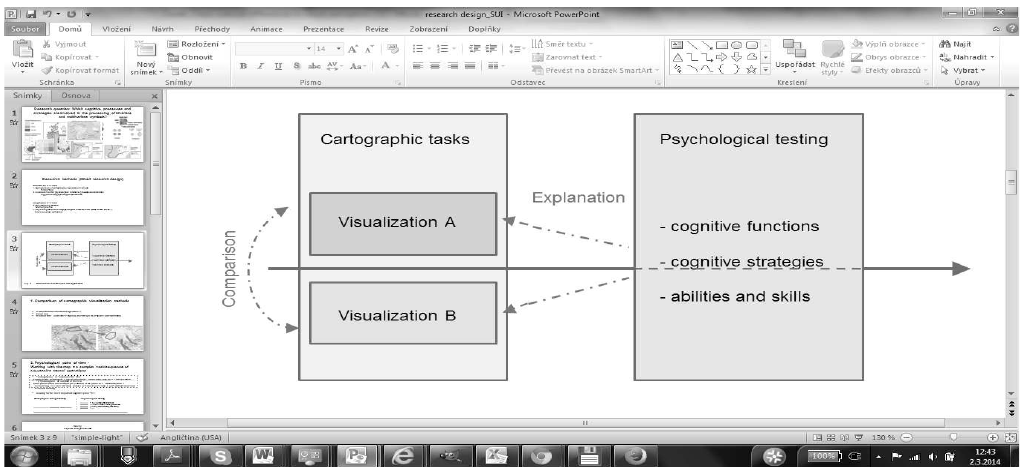
Fig. 7. Experiment combined with correlation